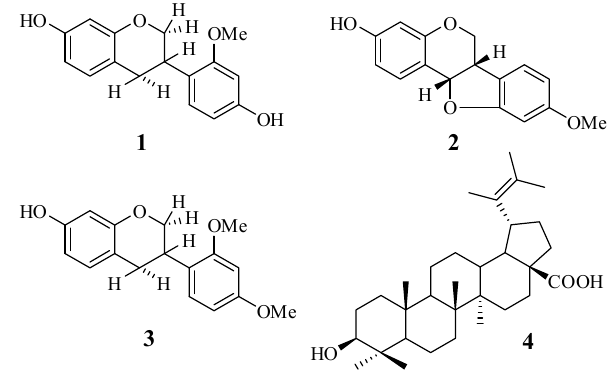
Figure 1. Chemical structures of the isolated compounds 1–4 .